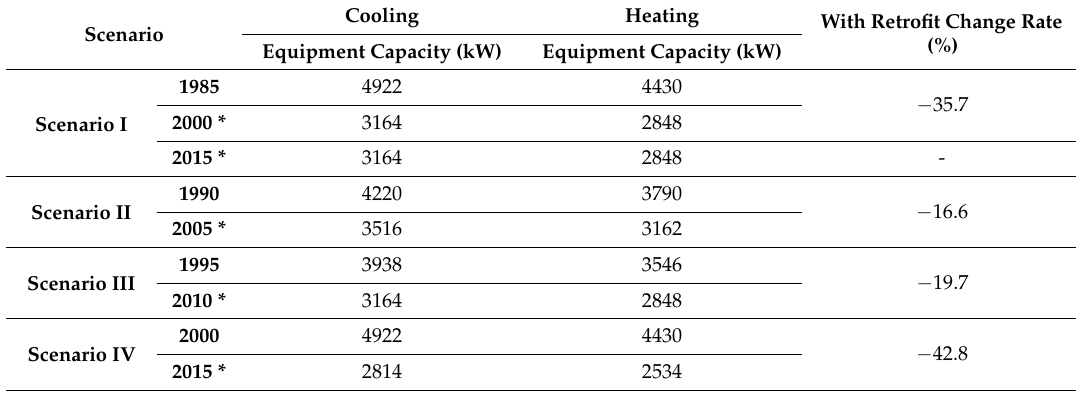
Table 13. Review of the capacity of absorption water heater/cooler for retrofit in each